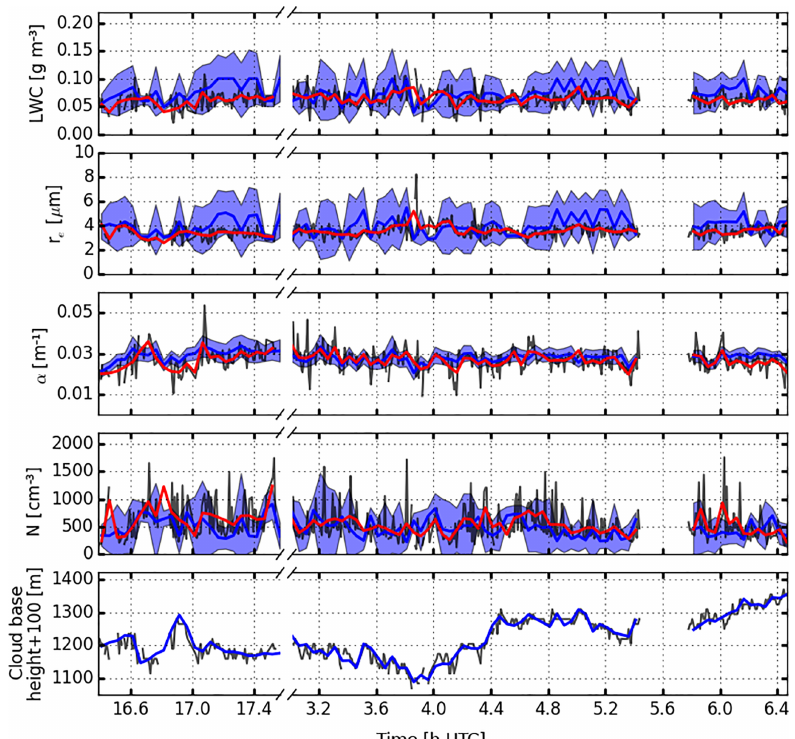
Figure 10. Time series of the optical and microphysical properties of the cloud at 100m above the cloud base. The break along the horizontal axis marks the change of day from 25 to 26 October. The data around 5.6UTC are deemed unsuitable for retrieval using the depolarization lidar method. The cloud properties and their respective uncertainties derived using the depolarization method are shown by the blue lines and the shaded area. The results of our retrieval are represented by the black lines (temporal resolution: 30s) and red lines (time averaged to match the time stamps and the 180s resolution of the depolarization results). Top to bottom: liquid water content, effective radius, extinction coefficient, number concentration, and the altitude at which the cloud properties are evaluated.